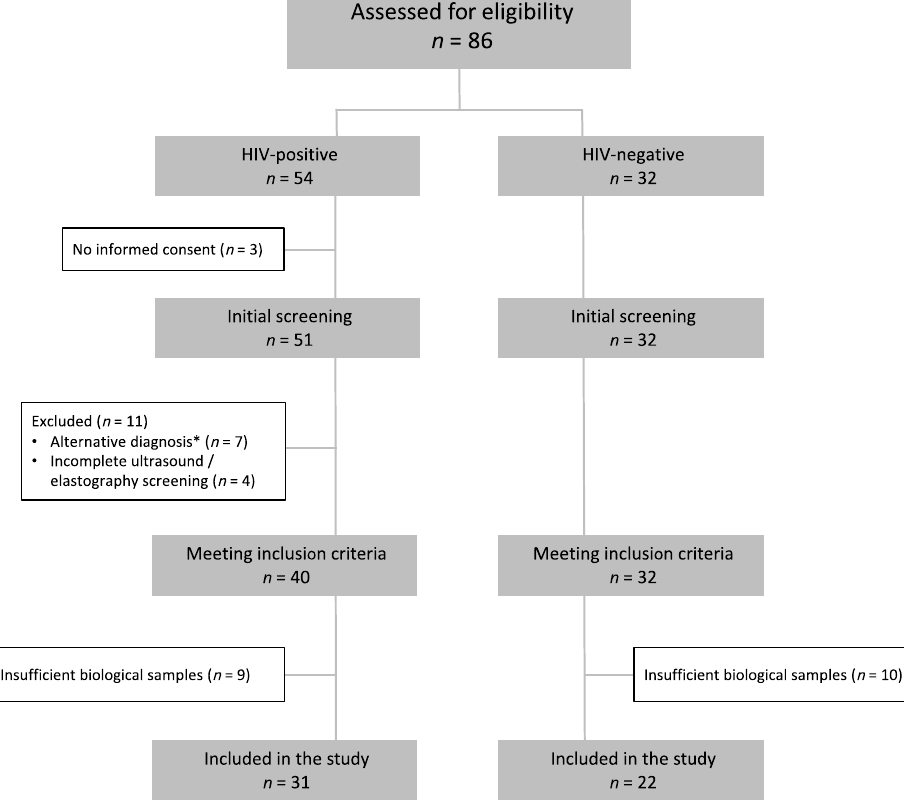
Figure 1. Study flowchart. Participants were assessed for eligibility if they met the study’s analytical inclusion criteria and did not have a diagnosed alternative liver disease. * Alterative diagnoses were: